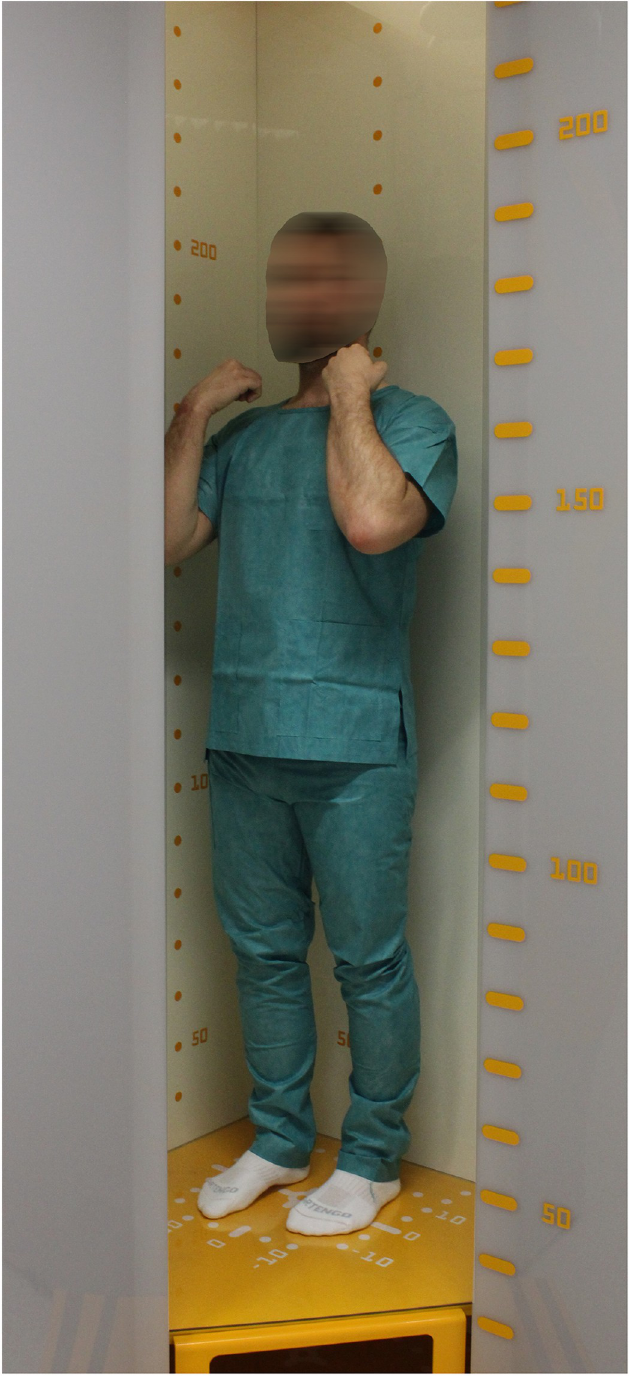
Fig 1. Patient position inside the EOS 2D/3D